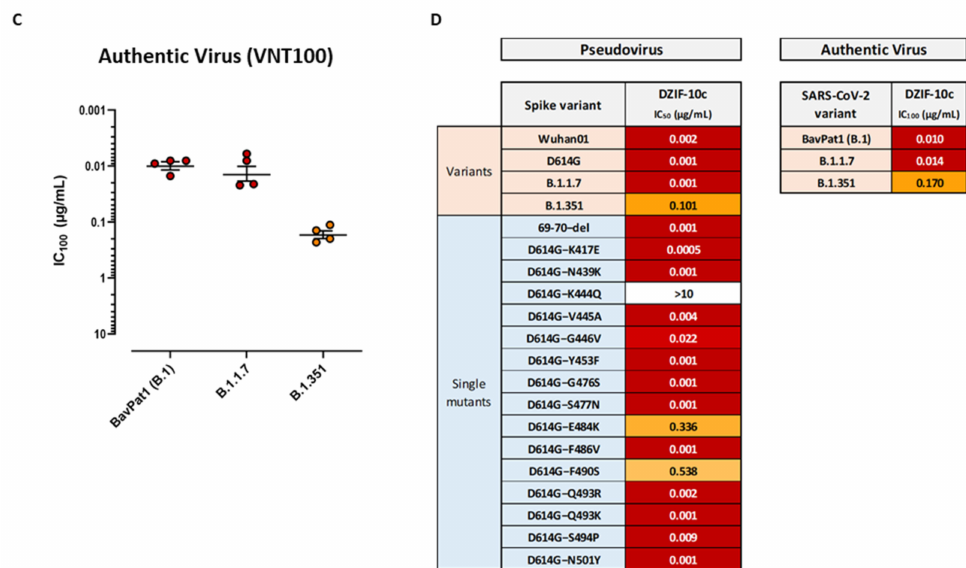
Figure 1. DZIF-10c binds and neutralizes SARS-CoV-2 with high potency. ( A ) Interaction of DZIF-10c, REGN10933 and REGN10987 with SARS-CoV-2 S RBD measured by ELISA. ( B ) Neutralizing activity of DZIF-10c against SARS-CoV-2 pseudoviruses bearing S proteins from different circulating strains. The dotted line indicates 50% neutralization (IC 50 ). ( C ) Neutralization of authentic SARS-CoV-2 (BavPat1, B.1) and SARS-CoV-2 variants B.1.1.7 and B.1.351 by DZIF-10c measured by VNT100. Neutralization was defined as the complete inhibition of CPE (IC 100 ). Circles represent geometric means from four independent experiments. Lines and error bars indicate the overall mean with SEM. ( D ) Summary of the neutralizing activity (IC 50 or IC 100 ) of DZIF-10c against SARS-CoV-2 pseudoviruses bearing various mutations in the S protein and against authentic SARS-CoV-2